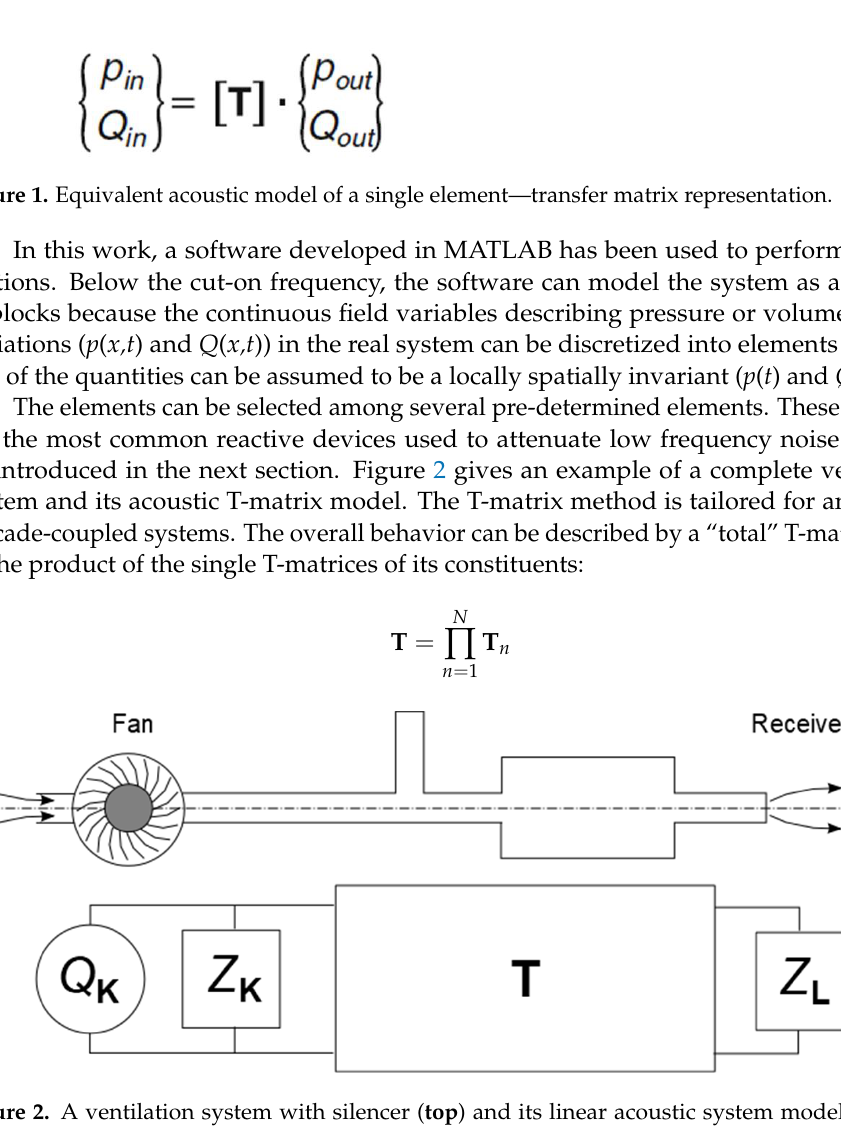
Figure 1. Equivalent acoustic model of a single element—transfer matrix representation.